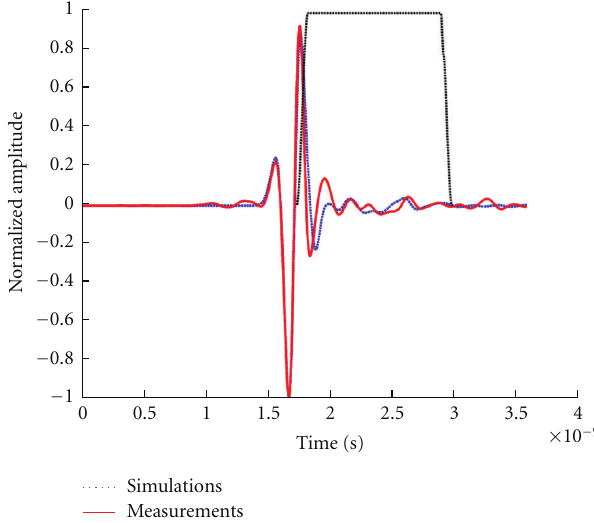
Figure 17: Reflections recorded in experiments and simulations. A Tukey window applied to isolate late-time reflections is shown. The reflections are normalized to the maximum value and shifted in order to align the skin